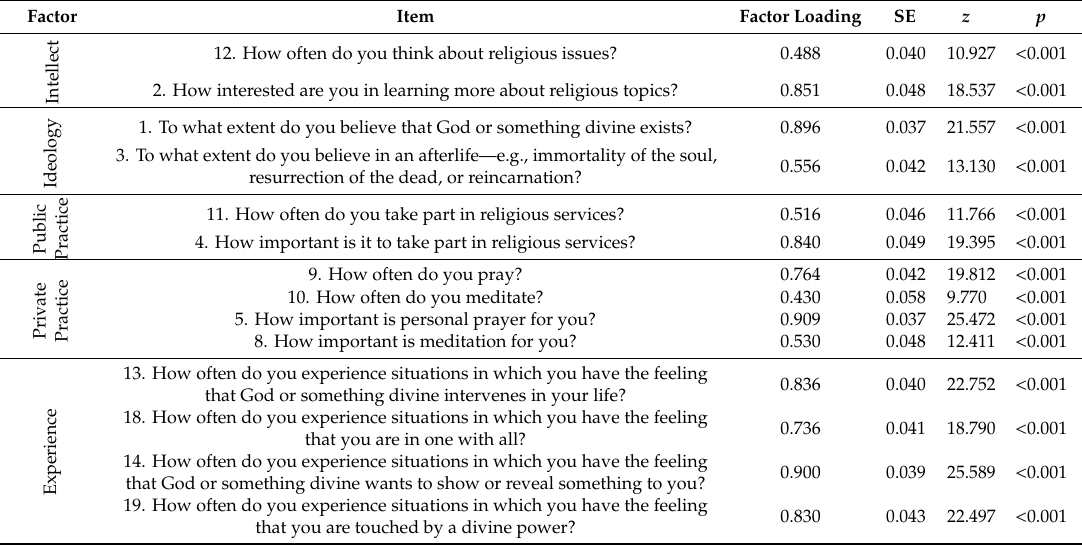
Table 4. Factor Loadings in Model 3, Five-Factor